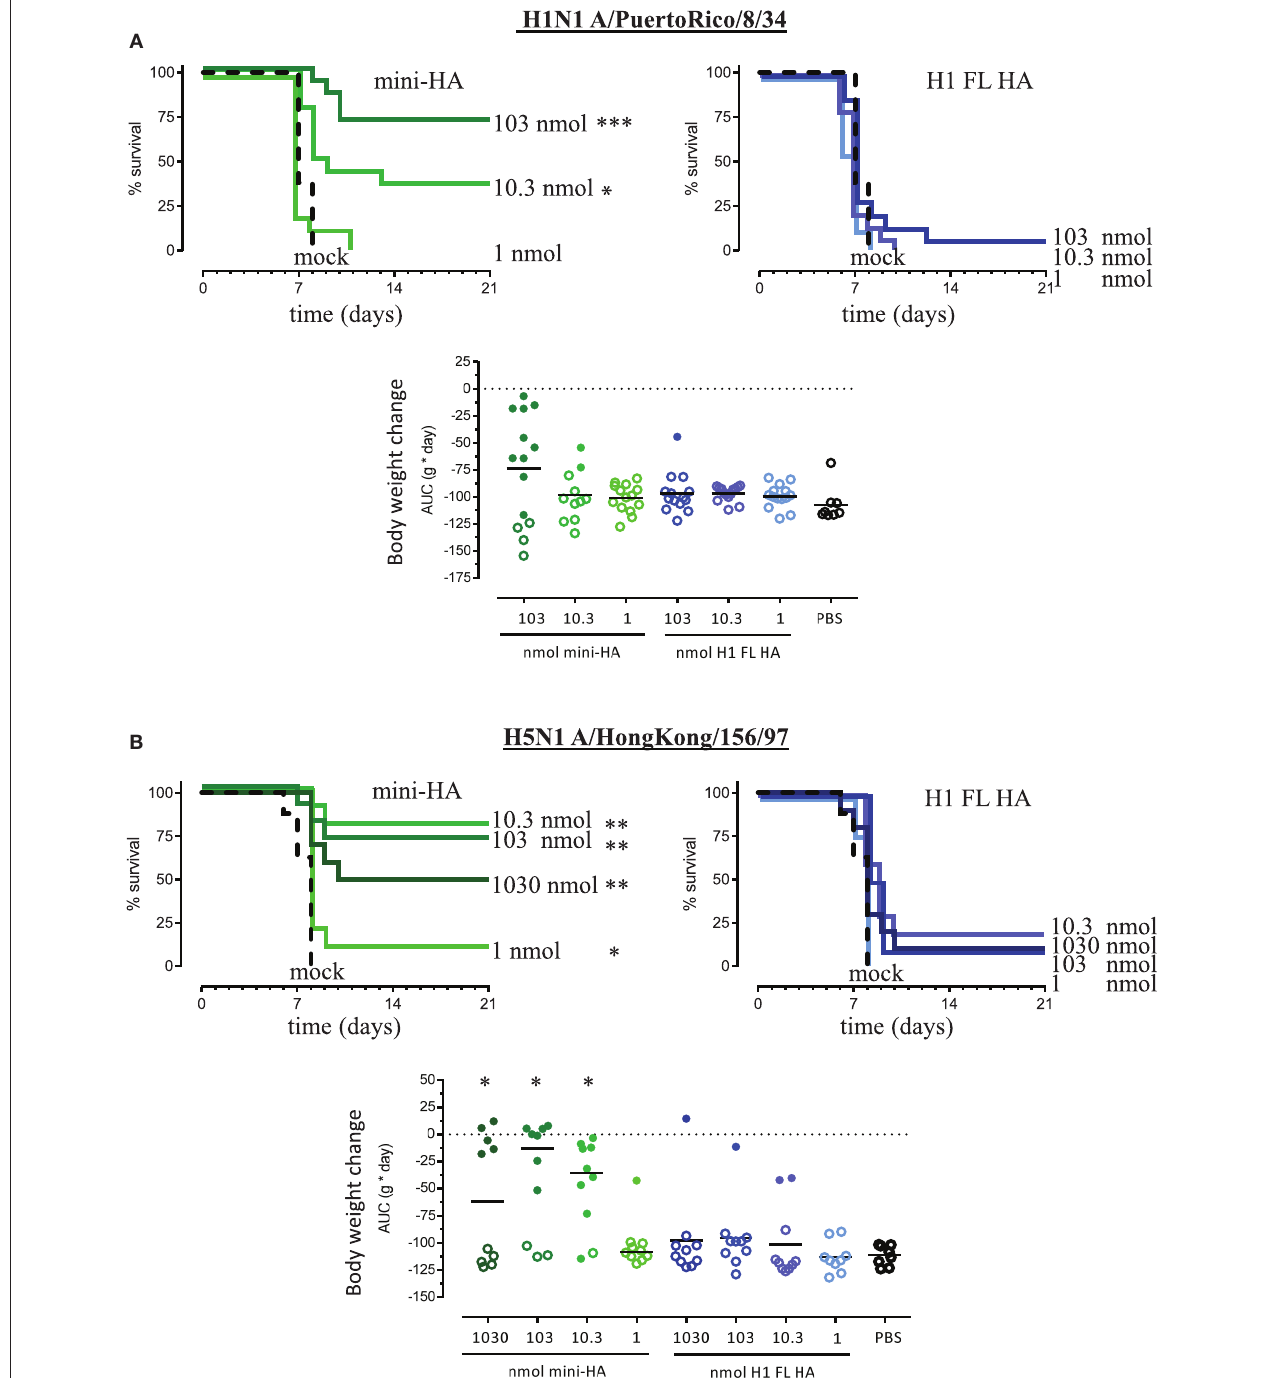
FIGURE 1 | Immunization with mini-HA but not H1 FL HA induces cross-protection against H5N1 and H1N1. Mice received 103 nmol (3 µ g mini-HA or 6 µ g H1 FL HA), 10.3 nmol (0.3 µ g mini-HA or 0.6 µ g H1 FL HA) or 1 nmol (0.03 µ g mini-HA or 0.06 µ g H1 FL HA) of the antigens. Four weeks after the third immunization mice were challenged with 12.5LD 50 of either influenza H1N1 A/PuertoRico/8/34 ( A , 14 mice per group) or H5N1 A/HongKong/156/97 ( B , 10 mice per group) and monitored 21 days for survival, body weight and median clinical score. 1,030 nmol (30 µ g mini-HA or 60 µ g H1 FL HA) vaccination was included only in the H5N1 challenge experiment. All mice in the mock control groups succumbed to the H1N1 and H5N1 challenge within 8 days. Upper graphs represent the Kaplan-Meier survival curves, lower graphs represent bodyweight change (gram x day) area under the curve (AUC). Solid lines indicate group medians, closed symbols indicated mice which survived subsequent influenza virus challenge. Asterisks indicate statistically significant differences in survival time or change in body weight compared to the mock immunized control group ( * p < 0.05, ** p < 0.01, *** p < 0.001 according to the material and methods section).